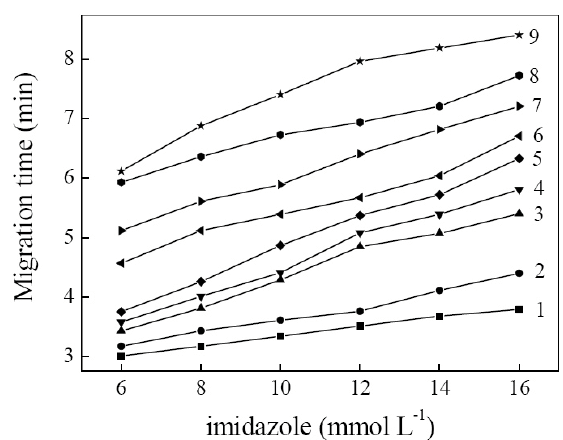
Figure 1. Effect of imidazole concentration on the separation of inorganic